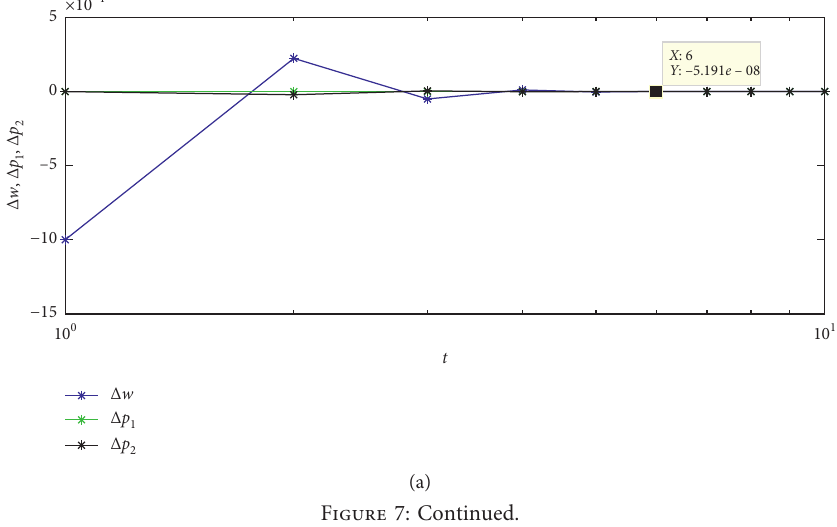
Figure 6: Chaos attractor of the dynamic system (9) with respect to α